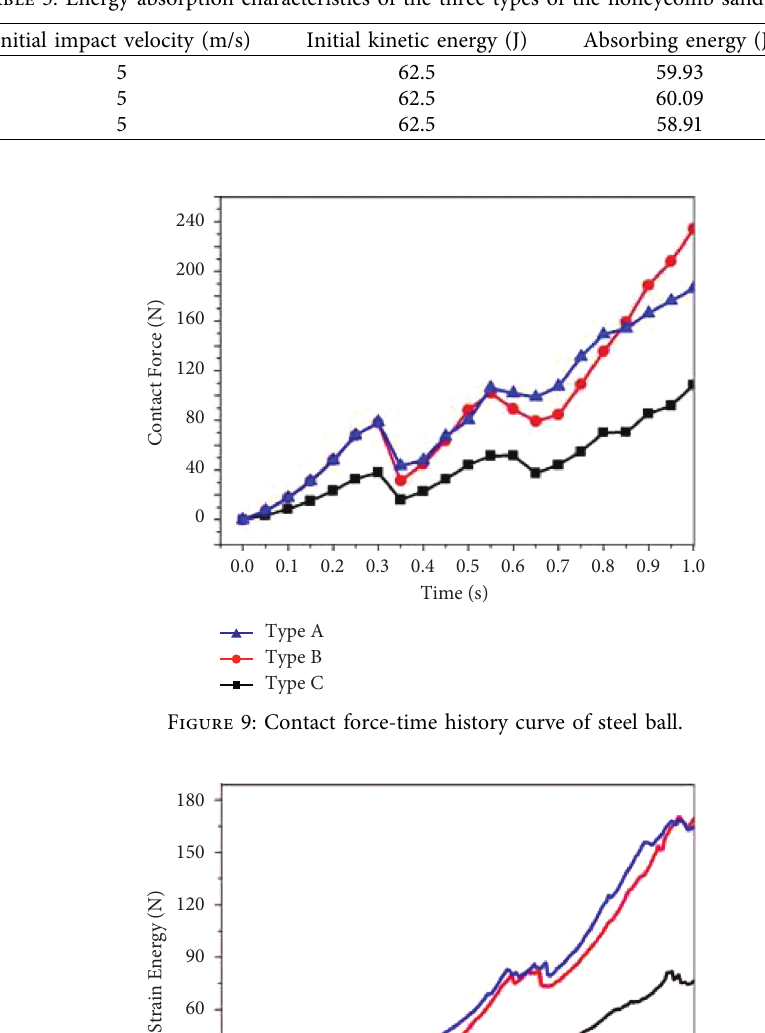
Table 5: Energy absorption characteristics of the three types of the honeycomb sandwich plates.